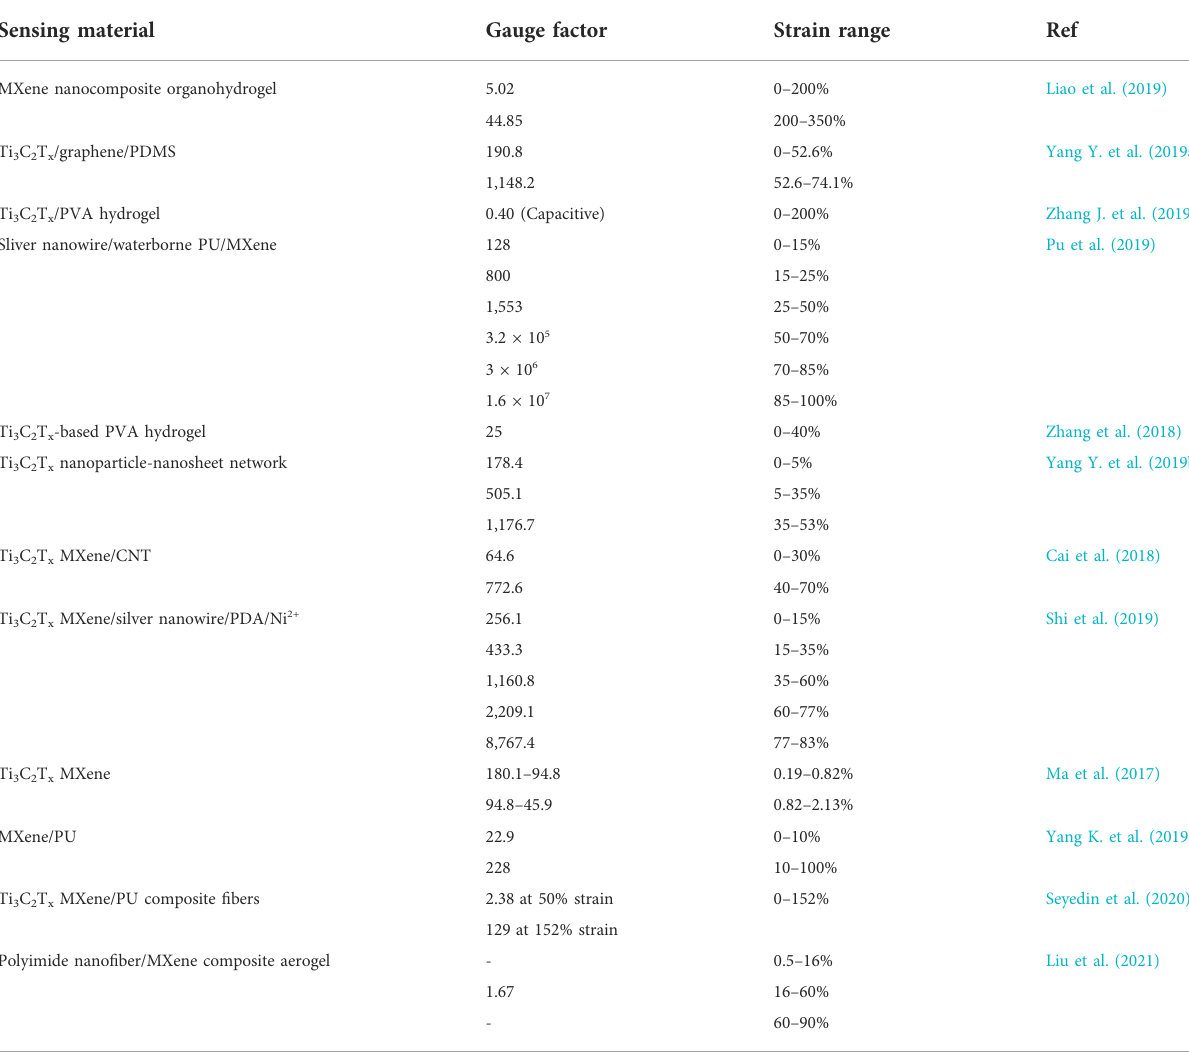
TABLE 2 Summary of MXene-based strain